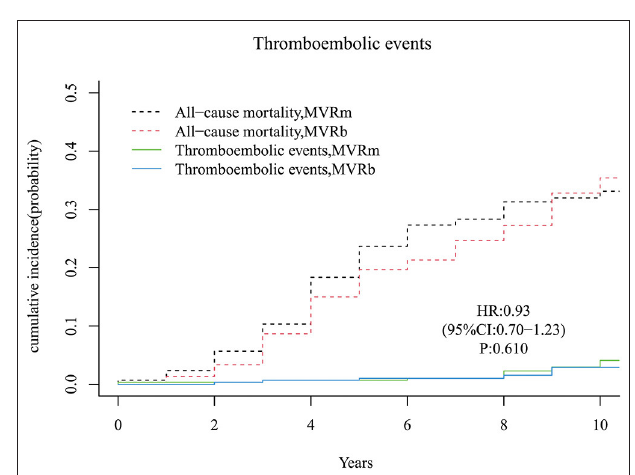
FIGURE 8 | Cumulative incidence of thromboembolic events. MVRm, mechanical mitral valve replacement; MVRb, bioprosthetic mitral valve